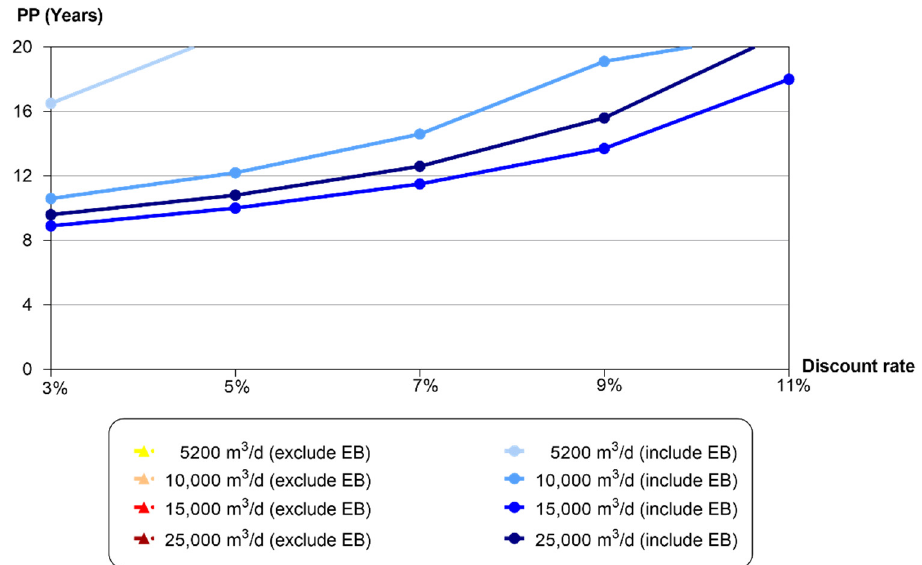
Figure 5. Payback periods (PPs) for water reclamation projects for industrial water supply when including and excluding environmental benefits (EB).